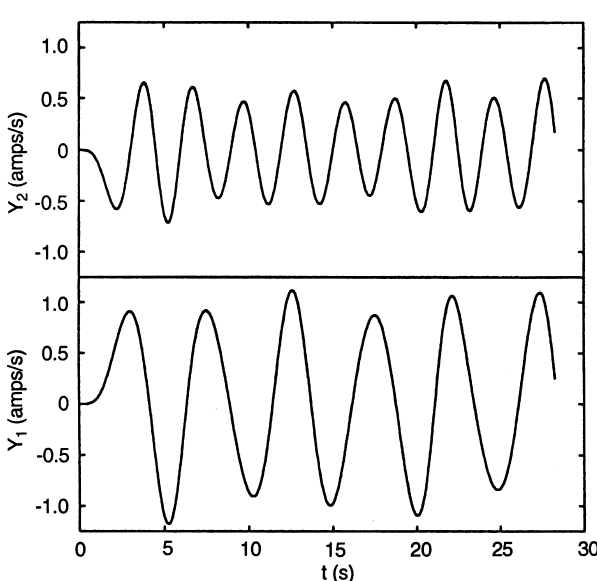
Fig. 2. The calculated values of the harmonics Y Y ( upper panel ). Y 2 chosen such that the mean amplitude of Y 1